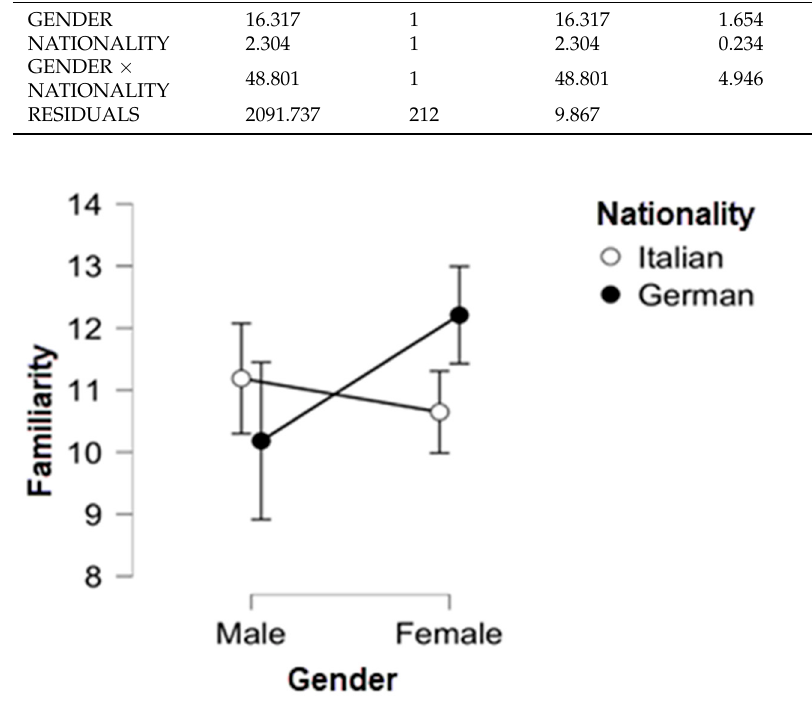
Figure 4. Descriptive plots of the statistically significant interaction GENDER × NATIONALITY on familiarity. Axes: Y = Familiarity scores; X = gender. The descriptive plots of the other items can be found in Supplementary Materials S2.